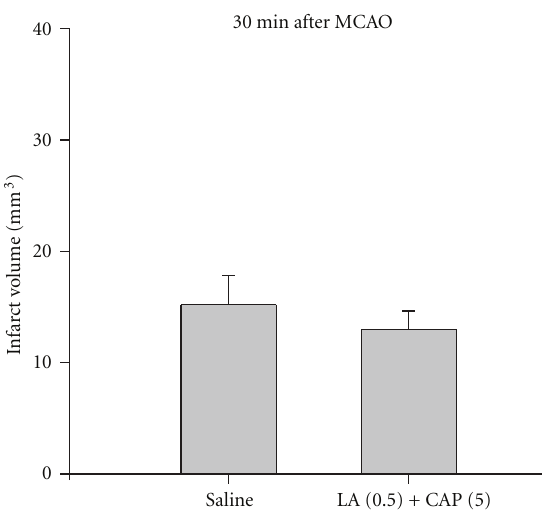
Figure 3: Average infarct volume (mm 3 ) following either saline ( n = 6) or a combination of captopril (5mg/kg) and lipoic acid (0.5mg/kg; n = 4) administration (i.v.) immediately prior to suture removal and the beginning of reperfusion (30 minutes after MCAO) calculated from TTC-stained coronal sections throughout the ex- tent of the infarct. Each bar represents the mean ±